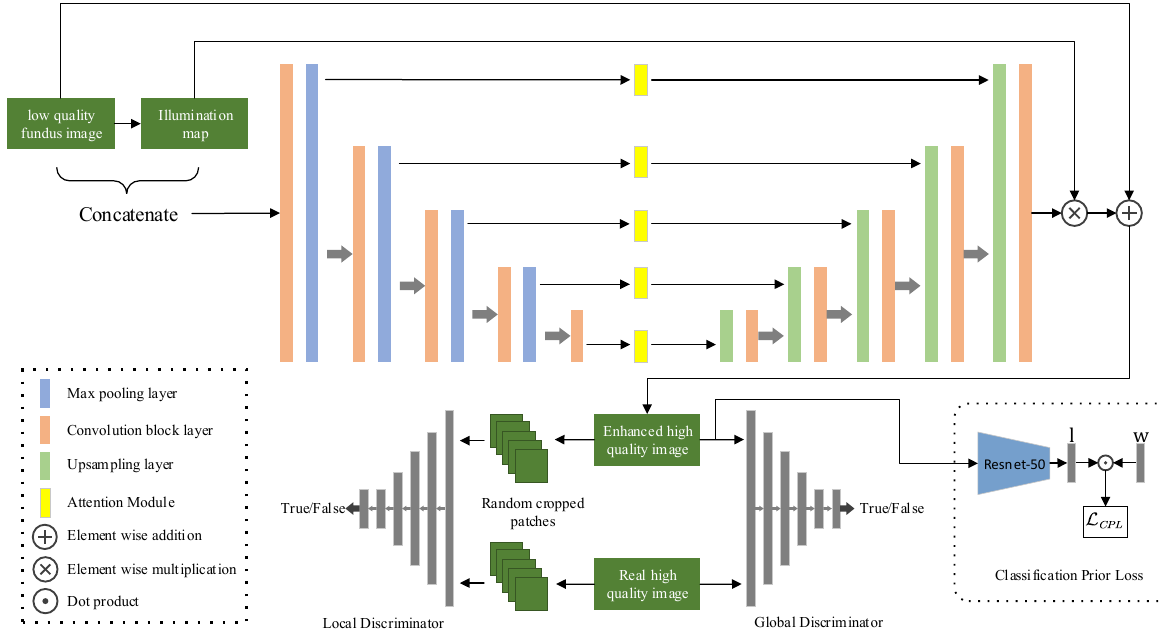
Figure 1. The overall architecture of our network.